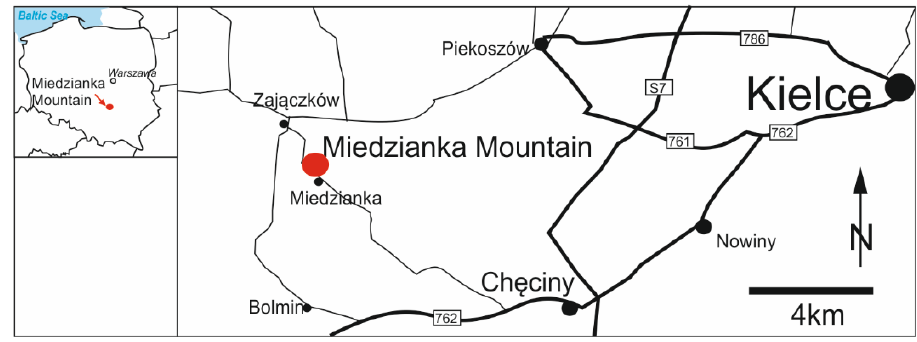
Figure 1. Location of the Miedzianka Mountain, compiled from Brygier, W. [28].